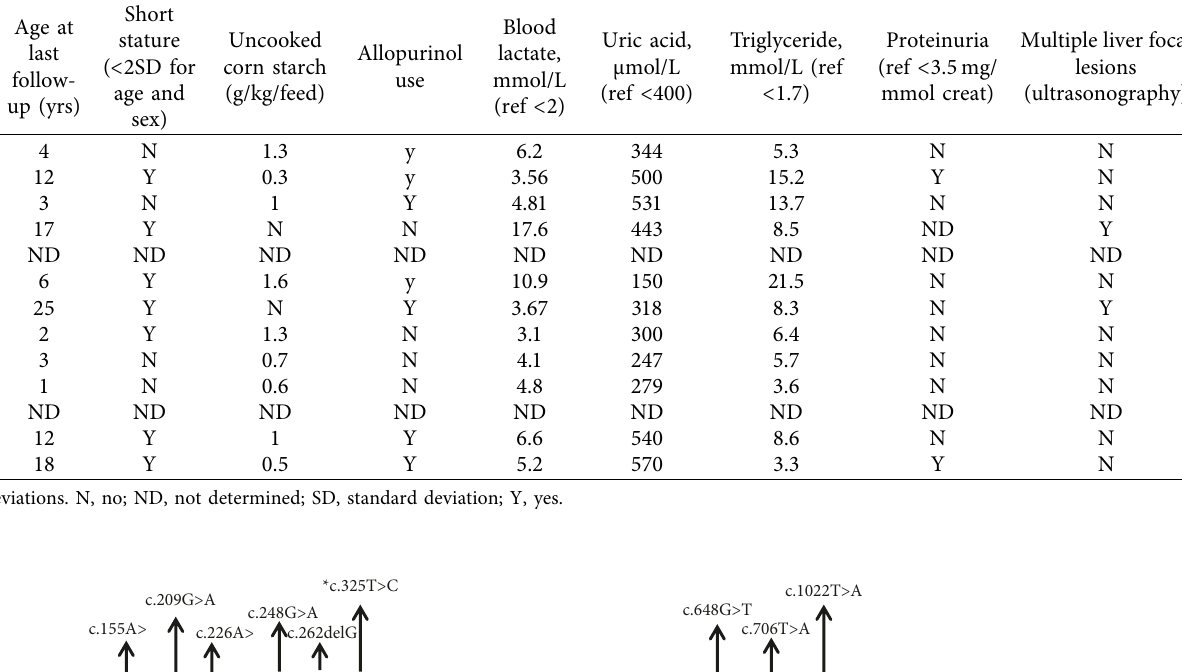
Table 2: Follow-up, treatment, and outcome of GSD1a Malaysians patients.